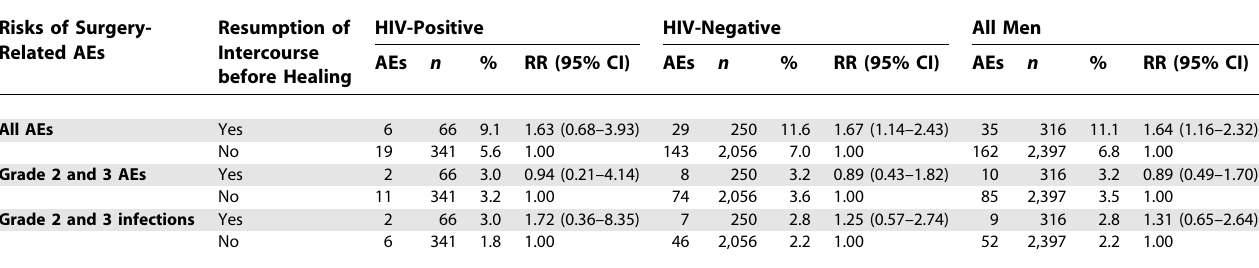
Table 3. Risks of Surgery-Related AEs by Timing of Resumption of Intercourse in HIV-Positive and HIV-Negative Men Risks of Surgery- Related